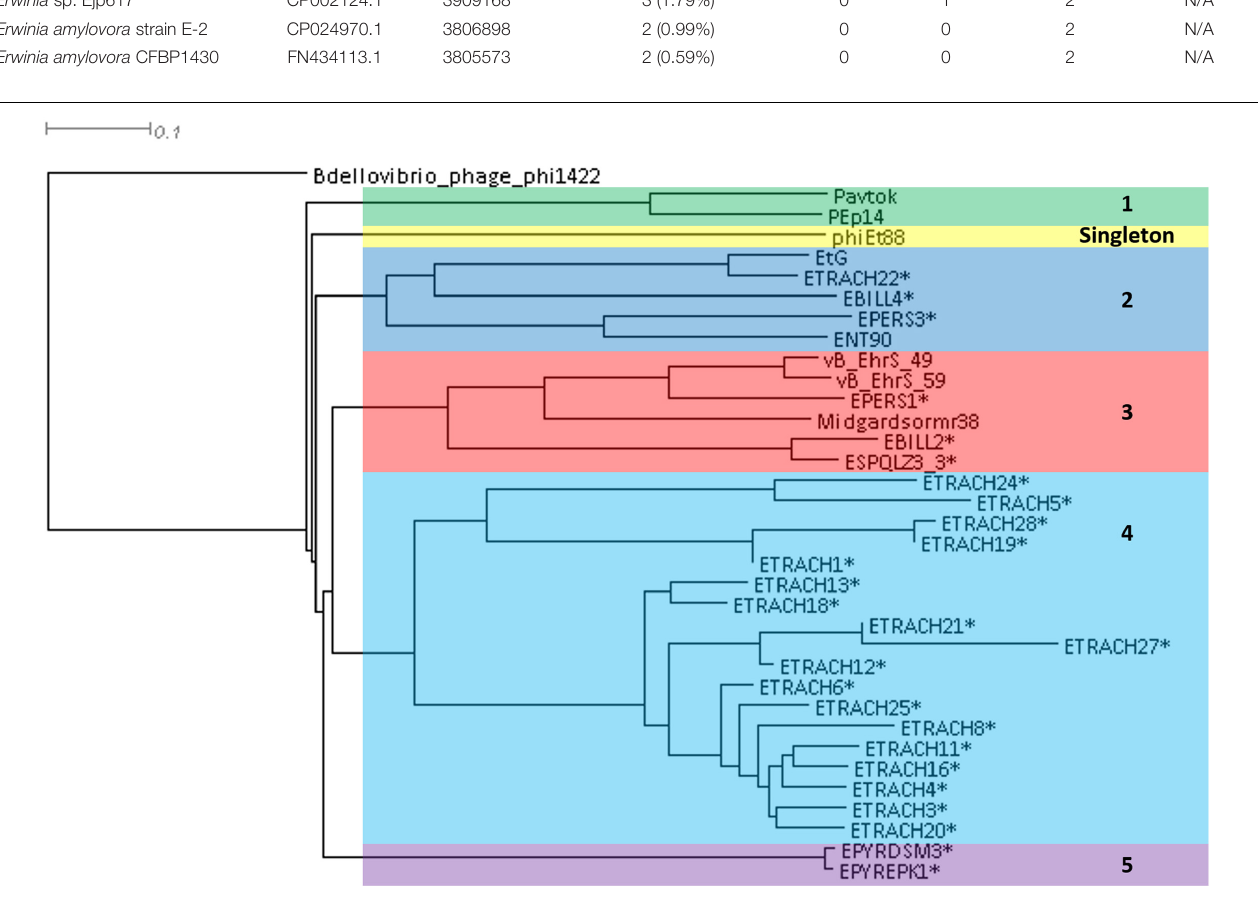
FIGURE 3 | Phylogram based on the complete genome fragmented alignment of temperate Erwinia phages and prophages. Cutoff threshold for non-conserved material was set to 5%. Bdellovibrio phage phi1422 resembles an outgroup. Colored rectangles indicate similar phage clusters and are numbered. Asterisk indicates prophages derived from Erwinia sp. chromosomes. Scale bar represents a 10% difference in average BLASTn score